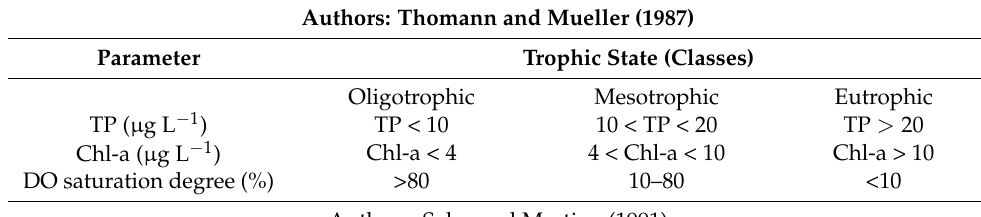
Table 1. Trophic classes according to the different models used to assess trophic state in tropical lakes and reservoirs.